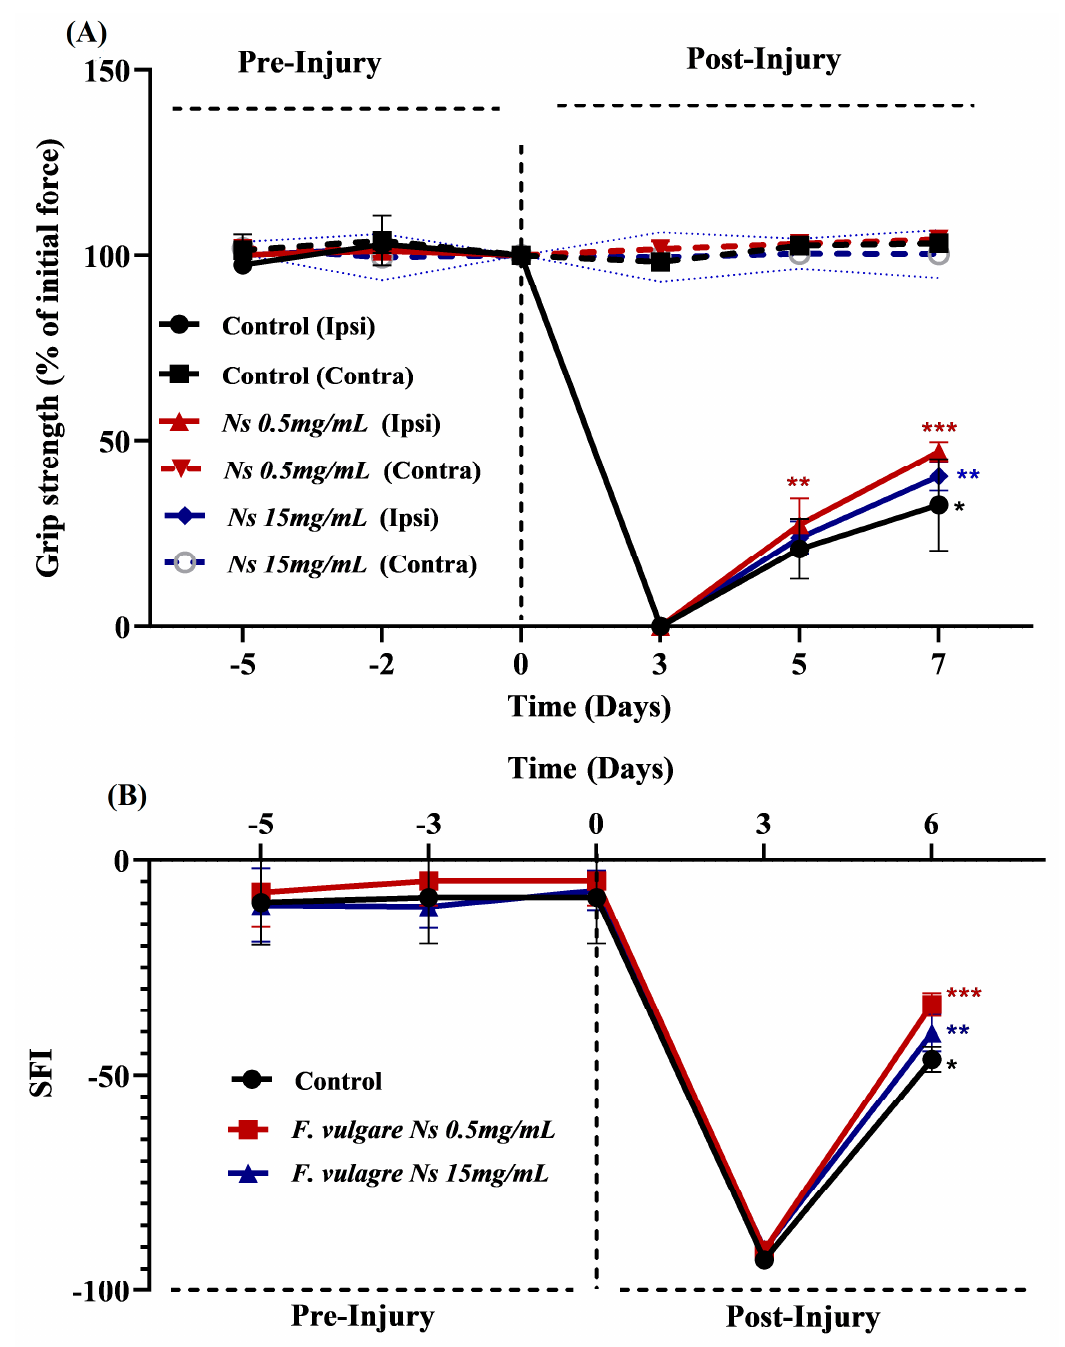
Figure 3. Influence of F. vulgare on ( A ) muscle grip strength and ( B ) SFI following sciatic nerve lesion. *, **, *** represents the significance of results/data.